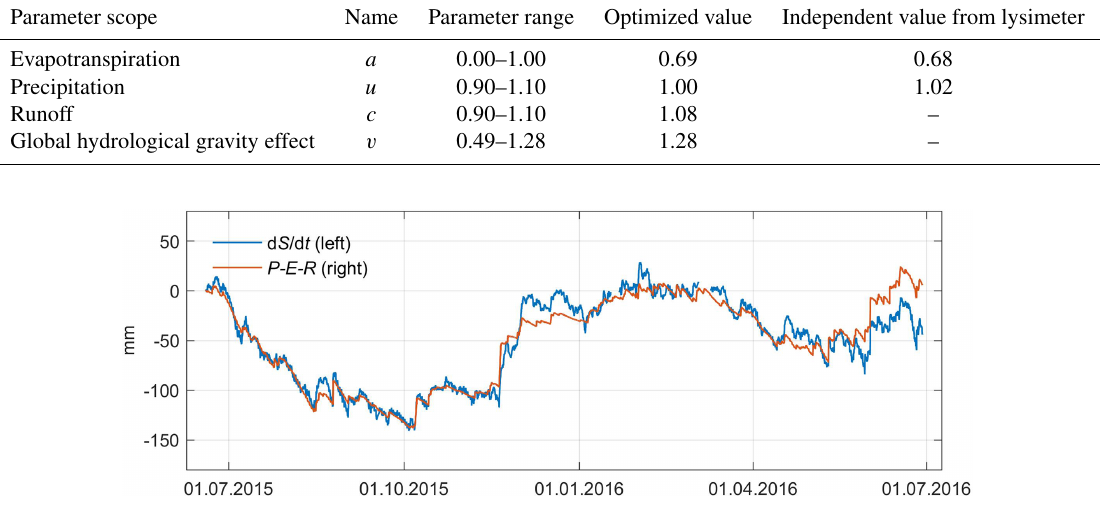
Figure 10. Time series of water storage at Wettzell (as a deviation from the initial storage value at the beginning of the study period, arbitrarily set to 0), with the measured iGrav006 gravity-based storage time series (blue line) (left side of Eq. 3) and the optimized storage time series (red line) after optimization following the right side of the water balance equation (Eq.